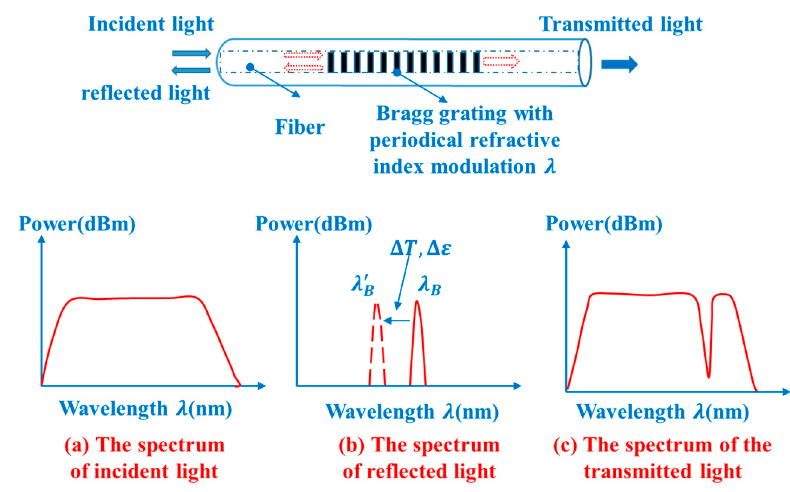
Figure 7. The schematic illustration of working principle of an FBG sensor.